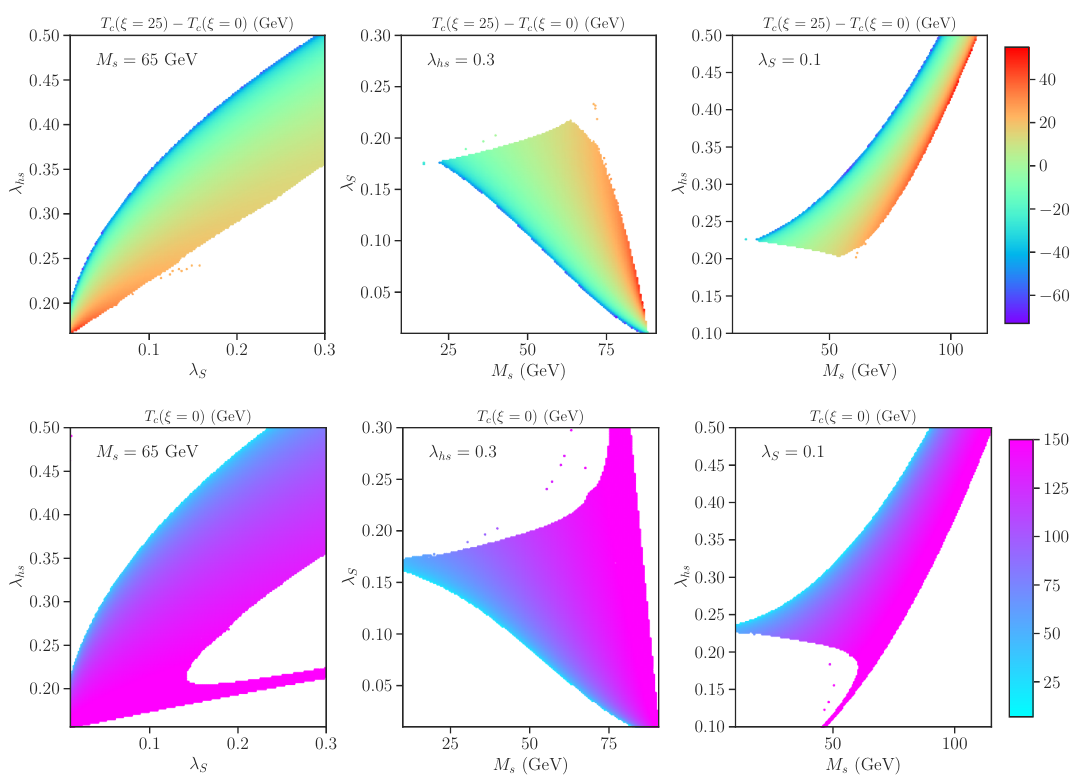
Figure 4 . Gauge-dependence of the MS + GC_SelfEnergy_Sol scheme for the critical temperature T c in two-dimensional scans. We use the difference in eq. (4.2) between ξ = 0 and 25 to show the gauge-dependence in the upper panels. We show the corresponding T panels. In the blank regions there are no points with a FOPT at ξ = 0 and ξ = 25